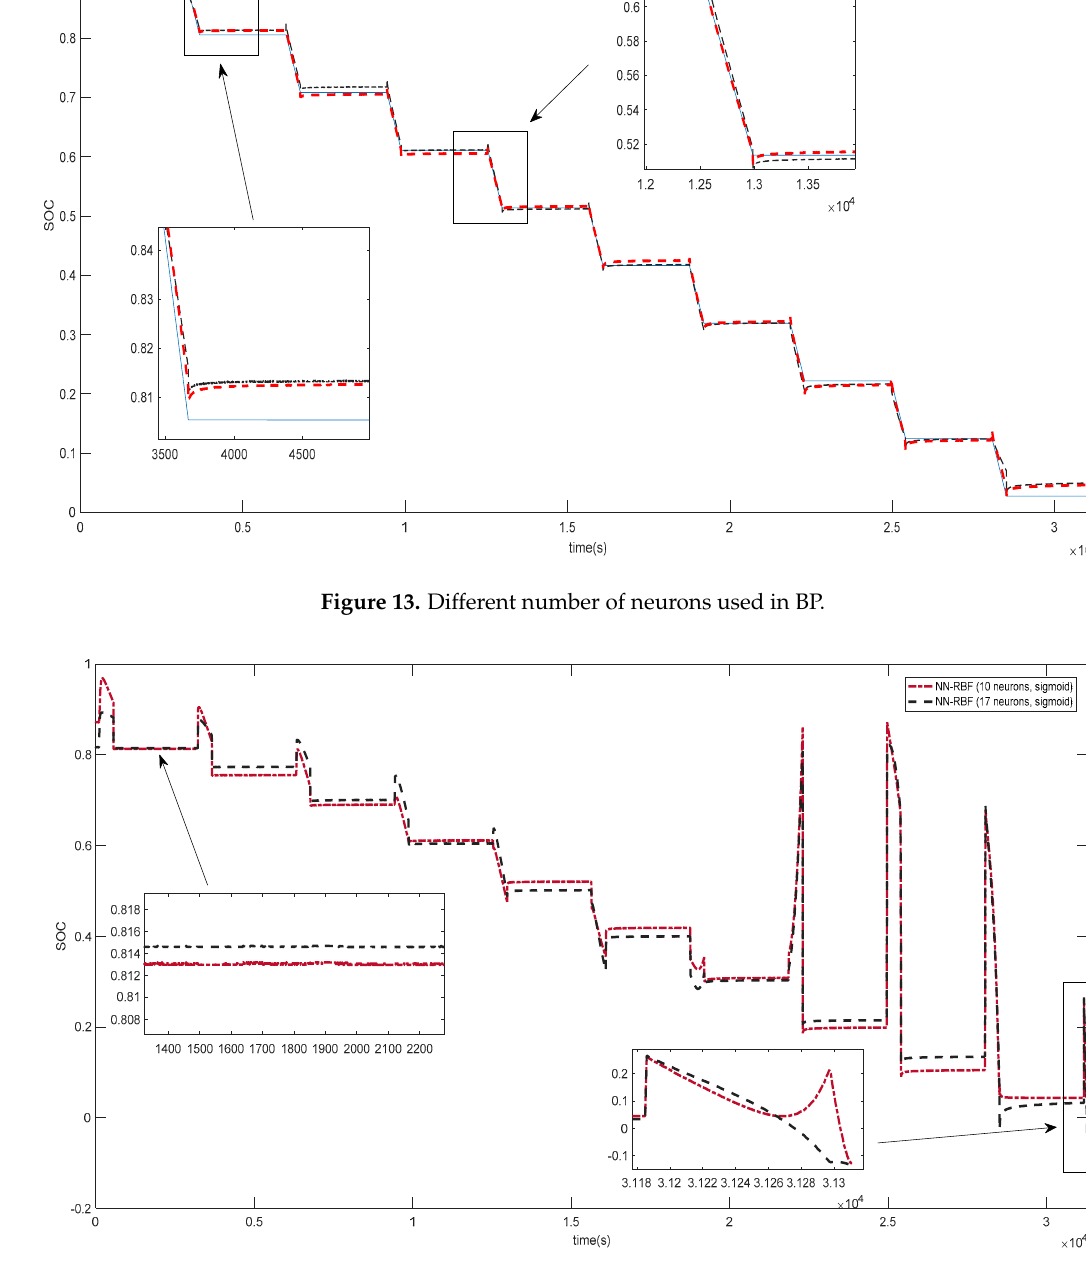
Figure 14. Different number of neurons in RBF. Table 8. Summary of RMSE and training time for backpropagation (BP), radial basis function (RBF) and basic ELM.